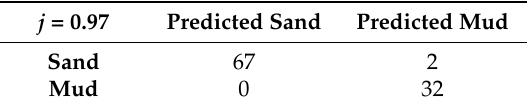
Table 6. Confusion matrix for classification from the first Neath flight using an artificial neural network fed with HSV and NIR data channels. Calculated j values for the classification are also given in the upper left cell. j = 0.97 Predicted Sand Predicted Mud